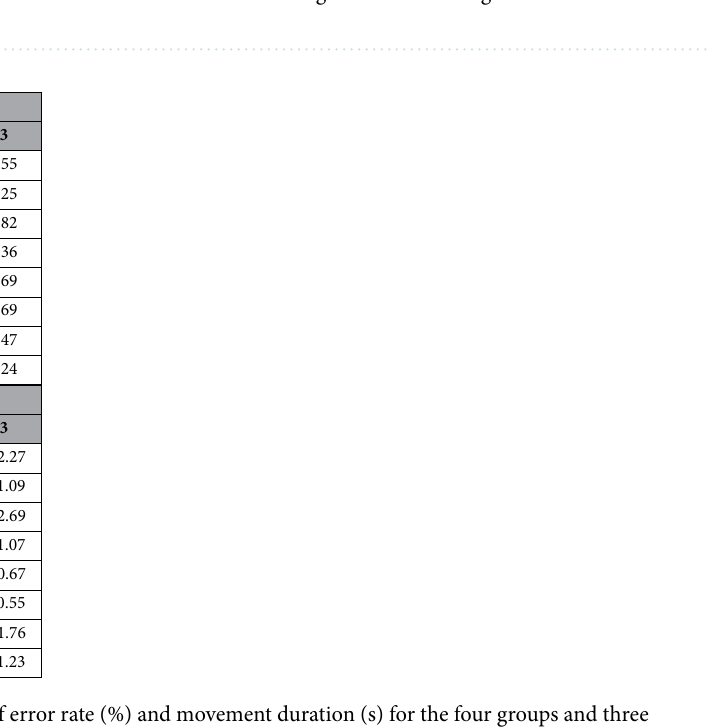
Table 1. Average value (+ SE) of error rate (%) and movement duration (s) for the four groups and three sessions.